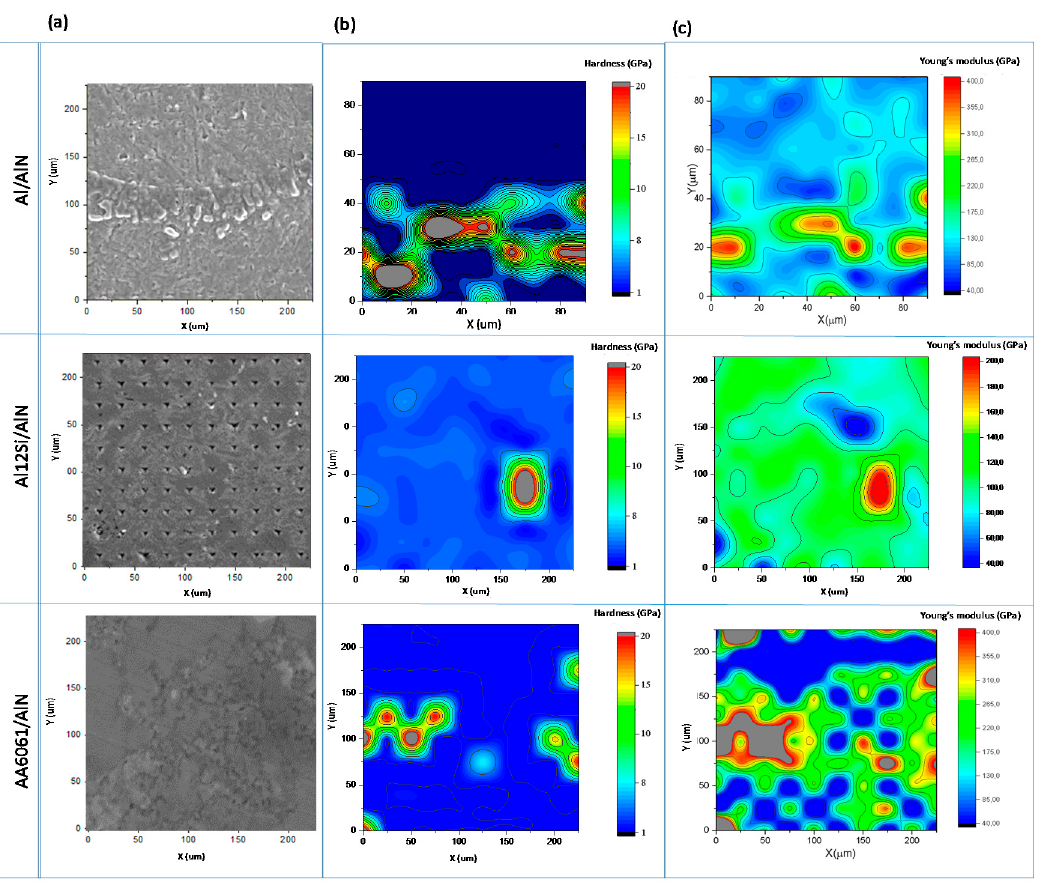
Figure 8. ( a ) Al / AlN, Al-12Si / AlN, and AA6061 / AlN microstructure; ( b ) Al / AlN, Al-12Si / AlN, Figure 8. ( a ) Al/AlN, Al-12Si/AlN, and AA6061/AlN microstructure; ( b ) Al/AlN, Al-12Si/AlN, and and AA6061 / AlN hardness map on the zone shown in a); ( c ) Al / AlN, Al-12Si / AlN, and AA6061 / AlN AA6061/AlN hardness map on the zone shown in a); ( c ) Al/AlN, Al-12Si/AlN, and AA6061/AlN Young’s modulus map on the zone shown in Young’s modulus map on the zone shown in a).